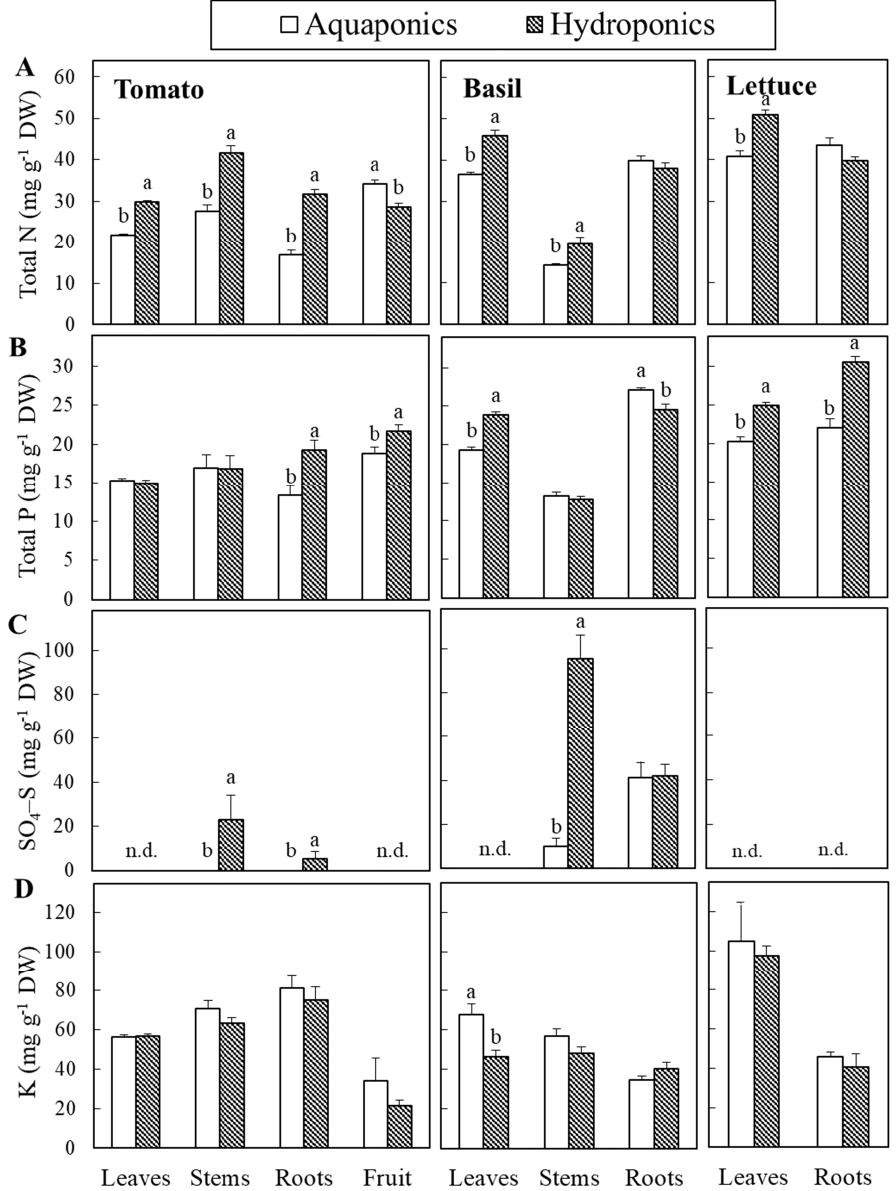
Figure 5. Total nitrogen ( A ), total phosphorus ( B ), sulfate ( C ), potassium ( D ) concentrations in leaves, stems, roots, and/or fruit of tomato, basil, lettuce grown for 3-, 3-, and 1-month(s) in an aquaponics or hydroponics system. Data represent the mean of 6 replicates ± SE.